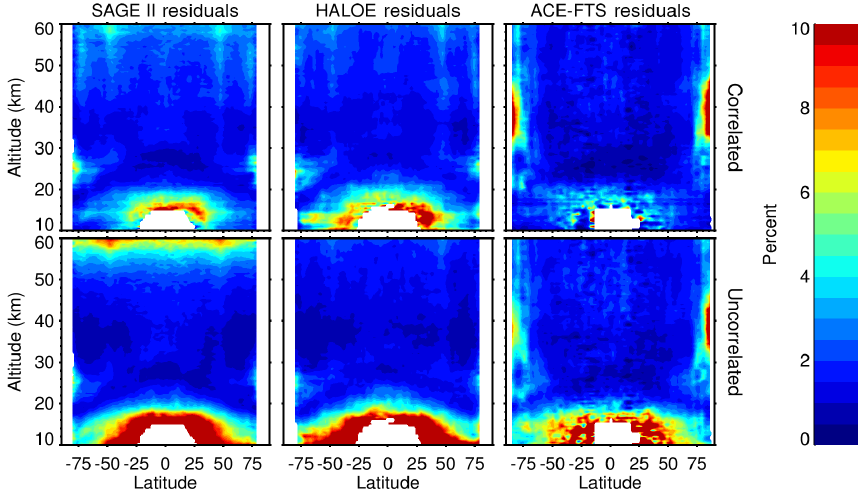
Figure 2. Spread of the correlated and uncorrelated residuals as a function of latitude and altitude for each instrument from the regression. White regions show areas where insufficient data